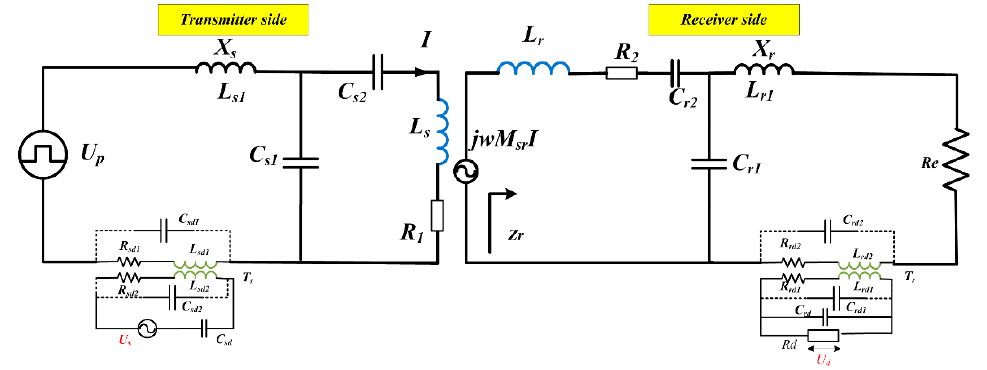
Figure 5. Circuit model of the proposed structure.